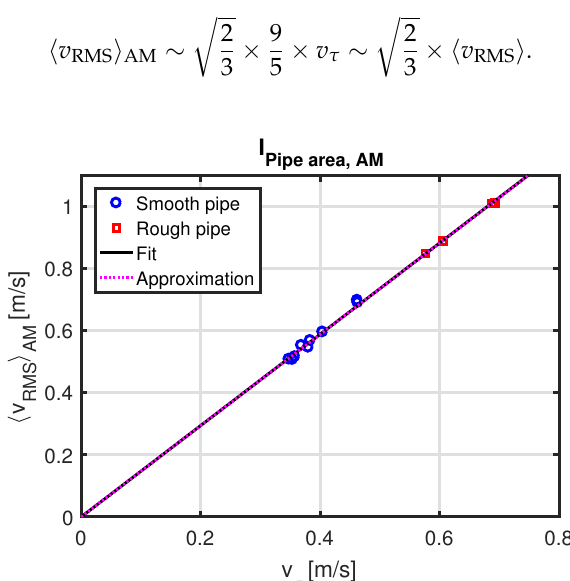
Figure A6. Relationship between friction velocity and the AM average velocity of the turbulent